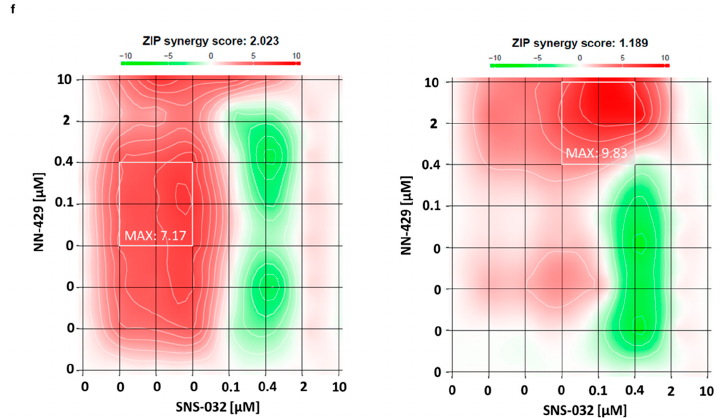
Figure 8. Synergy of NN-429 with clinical agents cytarabine, doxorubicin, etoposide, and with SNS- 032 in YT cells. ( a ) Box plot of ZIP synergy scores of NN-429 with doxorubicin, cytarabine etoposide, and SNS-032 in YT cells. ( b ) Box plot of MSA scores of NN-429 with doxorubicin, cytarabine, etoposide and SNS-032 in YT cells. Two representative interaction landscapes between ( c ) NN-429 and doxorubicin, ( d ) NN-429 and cytarabine, ( e ) NN-429 and etoposide, and ( f ) NN-429 and SNS-032 in YT cells. The MSA is outlined by a white square and the MSA score is indicated in the square.